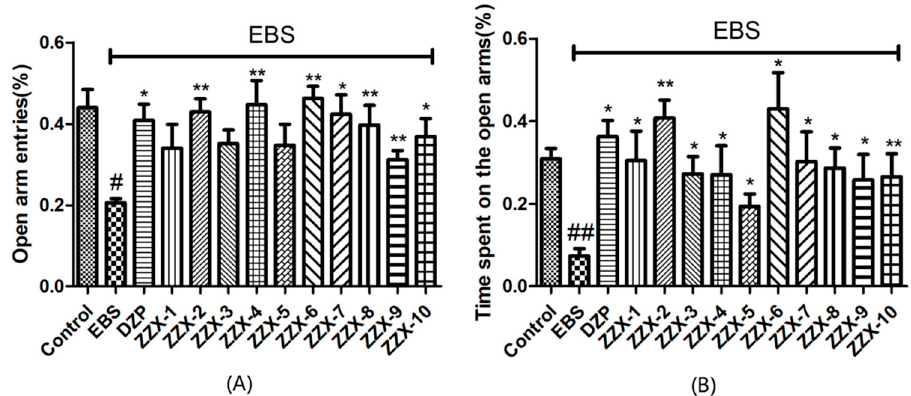
Figure 4. Effect of ZZX on the time spent on the open arms and the percentage of open arm entries in the elevated plus maze test in EBS rats. ( A ) Open arm entries (%); ( B ) time spent on the open arms (%). Bars represent mean ± SEM. # represent p < 0.05 compared to the control group; ## represent p < 0.01 compared to the control group; * represent p < 0.05 compared to the EBS/ZZX group; ** represent p < 0.01 compared to the EBS/ZZX group. One-way ANOVA with Student-Newman-Keuls post hoc test.